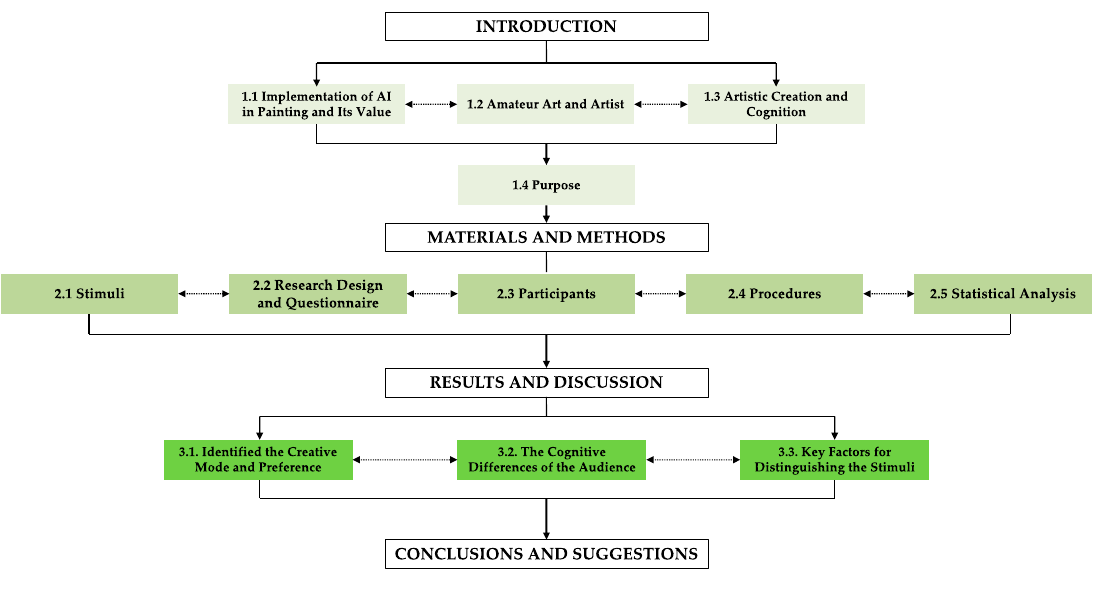
Figure 3. A broad overview of the research procedures.